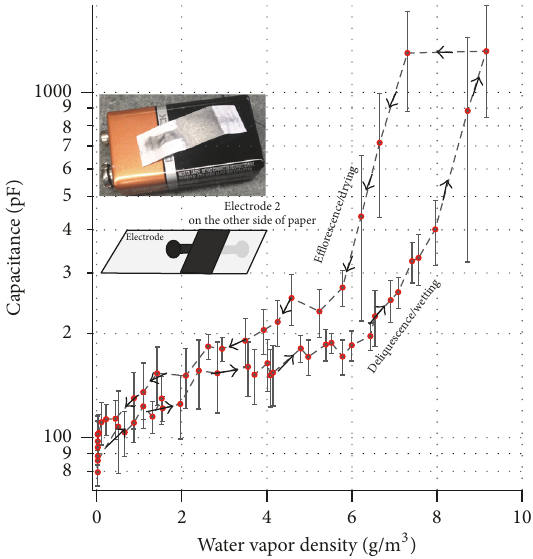
Figure 5: Measured capacitance of a 1cm 2 pencil-on-paper chem- ical sensor plotted versus water vapor density. Error bars represent the standard deviation of replicate